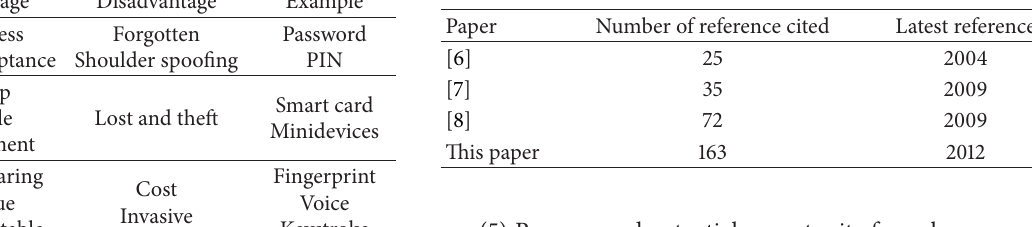
Table 1: Overview of different authentication approaches. Table 2: Comparison with existing survey paper on keystroke